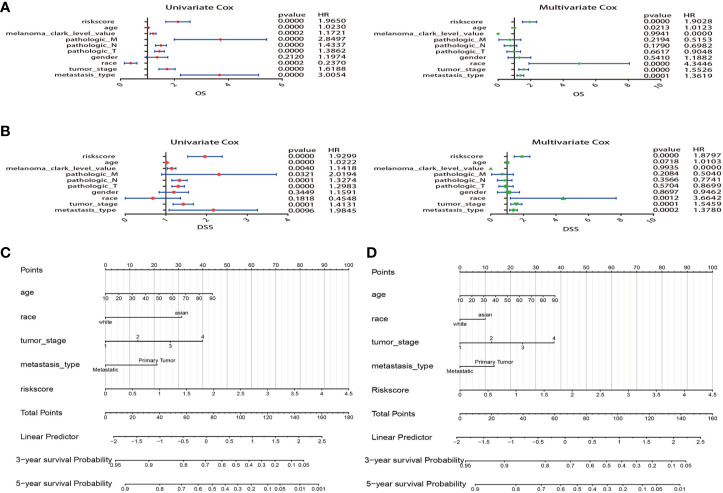
Construction of nomogram for overall survival (OS) or disease specific survival (DSS) prediction in melanoma. (A) Univariate and multivariate Cox regression analysis of risk score and clinical features by using OS time. (B) Univariate and multivariate Cox regression analysis of risk score and clinical features by using DSS time. (C,
D) The composite nomogram consists of the clinical features and risk scores of patients. Each component generates their respective points according to the “Points” line drawn above. Add the points from variables together and find the location of the total points on “Total Points” line. Then draw a vertical line from “Total Points” axis to the two lower lines which corresponds to the predicted 3-year and 5-year survival (OS and DSS) rates by the nomogram.